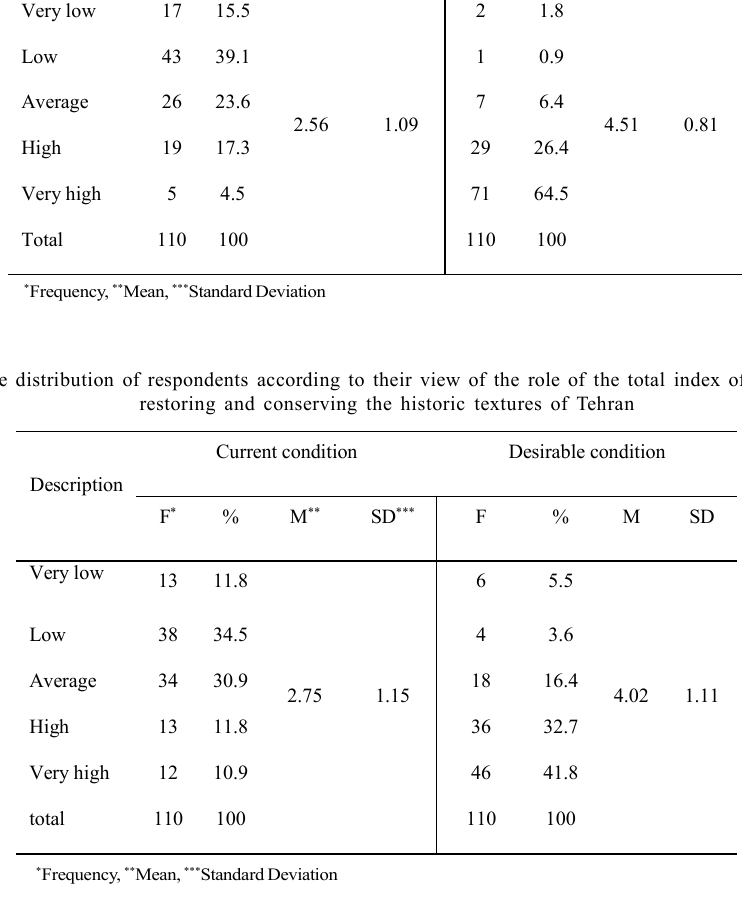
Table 4: Relative distribution of respondents according to their view about the role of the total index of management factors in conservation and restoration of the historic textures of Tehran